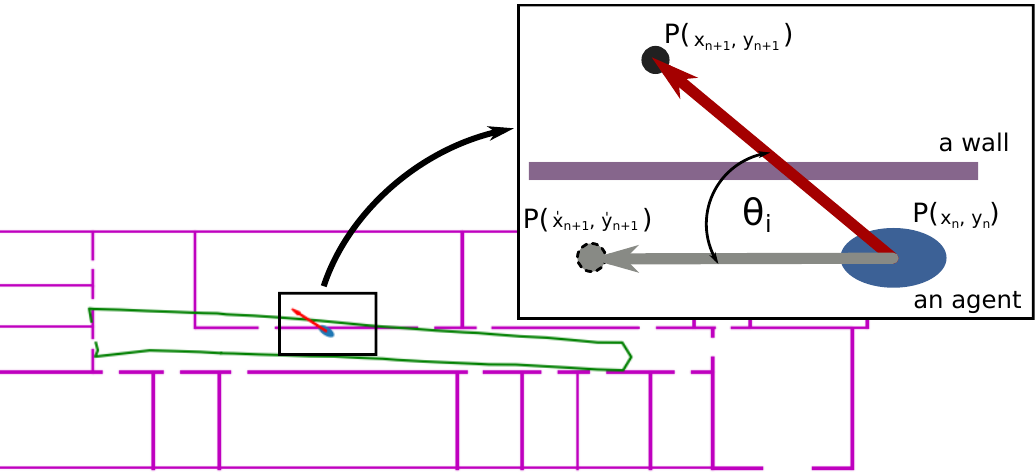
Figure 4. A correction of the position—the agent collides with a wall. Ellipsis reflects the agent; purple lines define obstacles; the red arrow defines the velocity vector (as a subtraction of the position from INS and the agent’s current position); the gray arrow defines the collision avoidance velocity; the green line is the original path sent by the radio device. P ( x n , y n ) is the current position of the agent; P ( x n + 1 , y n + 1 ) is the next position obtained from INS; θ i is an angle for velocity rotation in order to avert collision; P ( ´ x n + 1 , ´ y n + 1 ) is the corrected